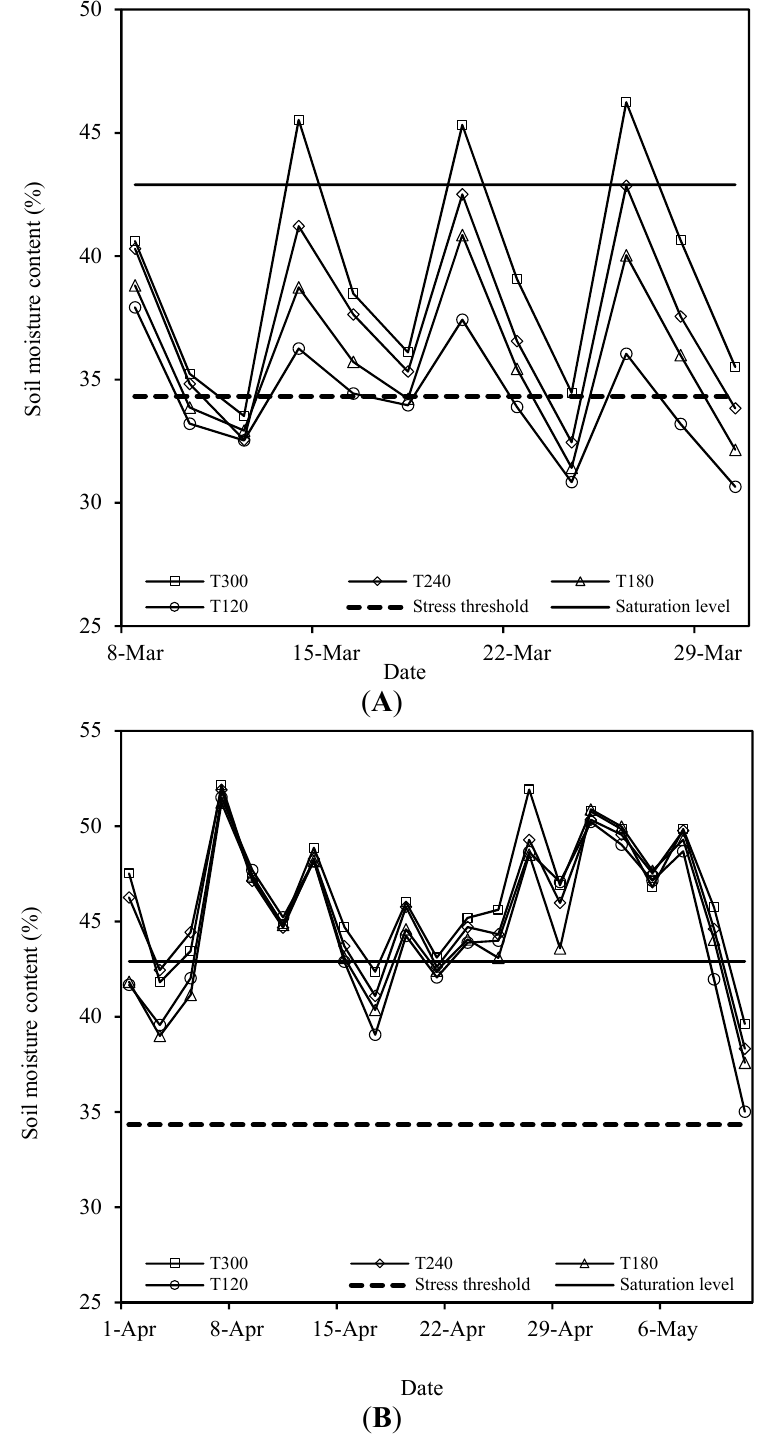
Figure 2. Soil moisture content in different treatments at the vegetative stage ( A ) and from panicle initiation to heading ( B